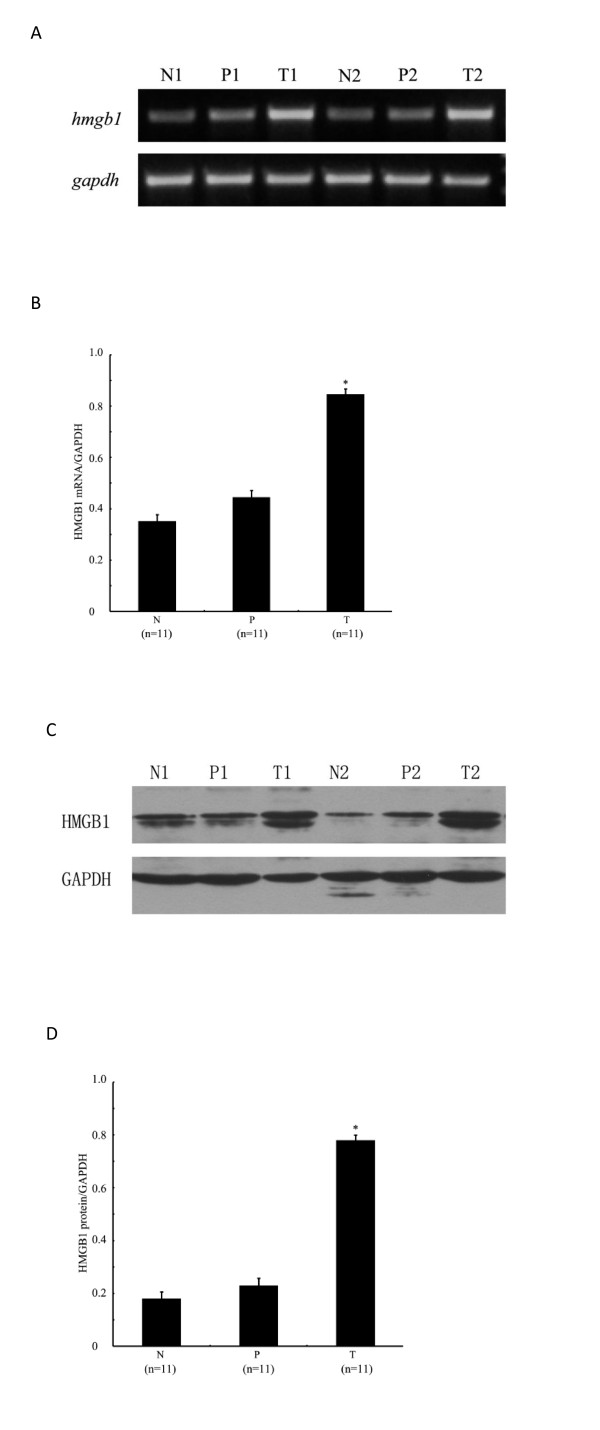
RT-PCR and Western blot analysis of HMGB1 expression in normal (N), para-tumor (P) and tumor tissue (T) of all 11 HCC cases fresh tissues. (a) Representative RT-PCR results of two cases, and (c) Representative Western blot results of two cases. (b) Relative quantity of HMGB1 mRNA expression, and (d) protein expression. Each value which represents the average of 11 cases expressed as the mean ± SE. Human GAPDH served as an internal control, the gray-scale comparison between HMGB1 and GAPDH was used to quantify the bands of RT-PCR and western blot results. * p < 0.001, compare to normal (N) and para-tumor (P).